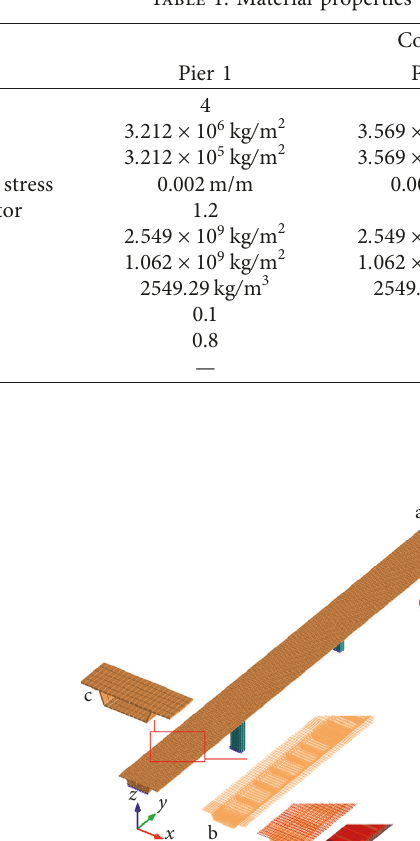
Table 1: Material properties of bridge piers [17].